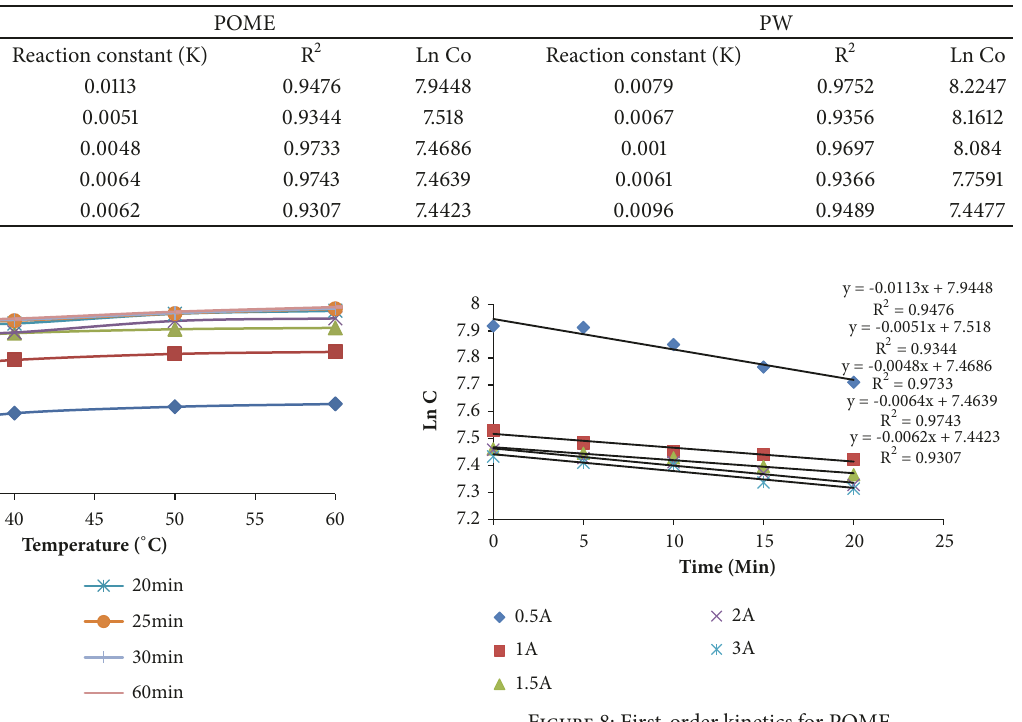
Figure 7: Effect of temperature, at varying time for PW at current density of 3A and pH of 6.